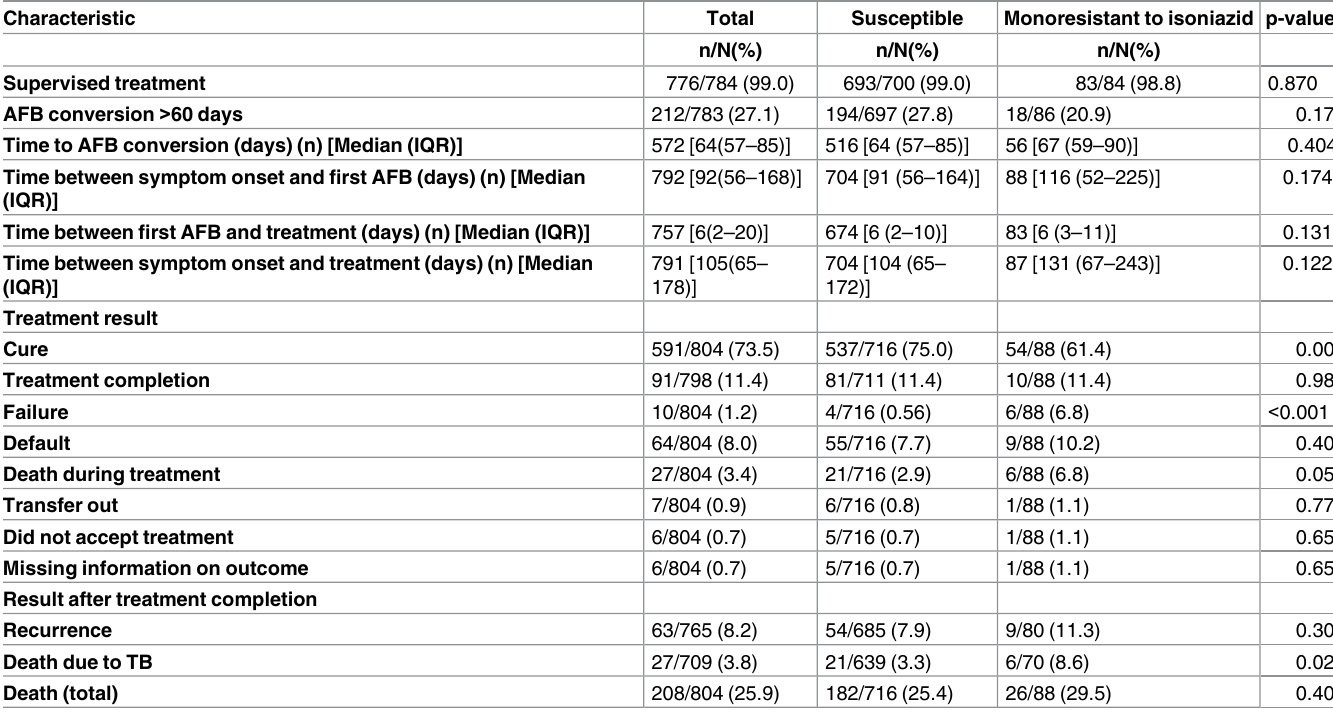
Table 4. Treatment Outcomes Among Pulmonary Tuberculosis Patients According to Drug Susceptibility. Orizaba, Veracruz, 1995–2010